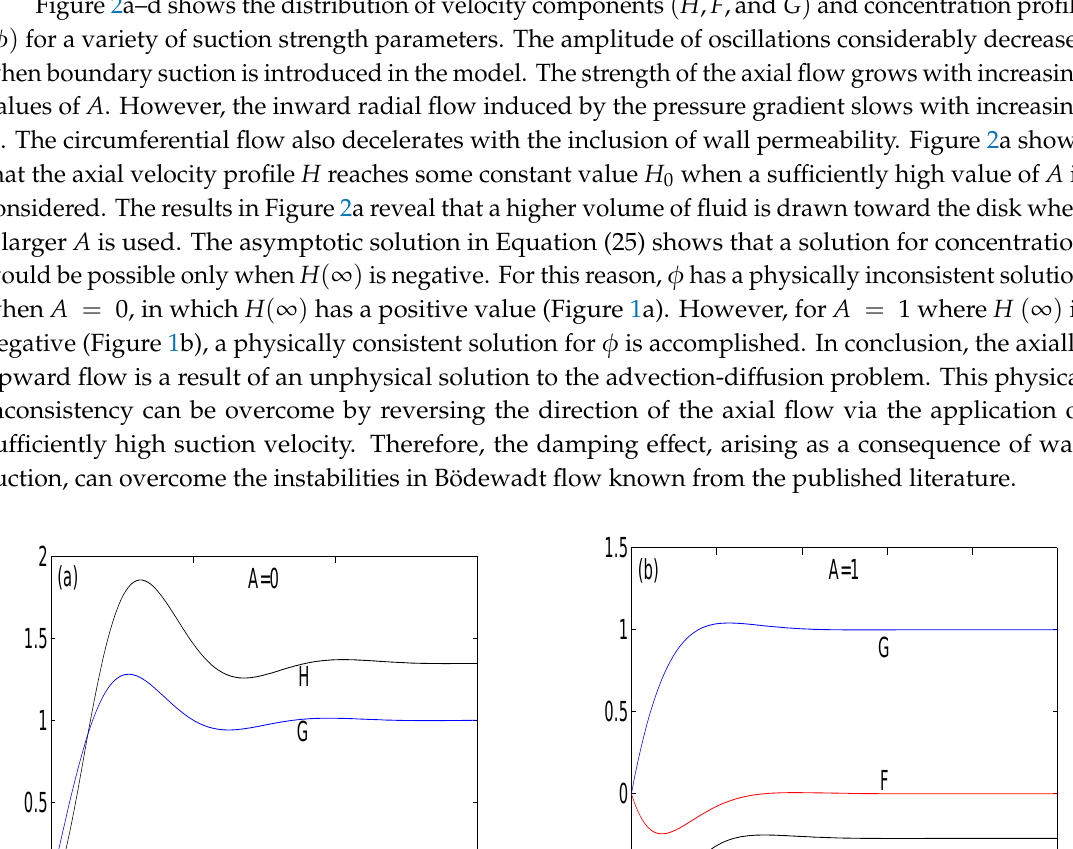
Figure 2. Velocity components ( 𝐻, 𝐹, and 𝐺 ) and 𝜙 for different values of 𝐴 . We determined the evolution of concentration profile 𝜙 at different values of involved parameters, as shown in Figure 3a–d. Graphs of 𝜙 against 𝜁 for various values of suction-strength parameters are depicted in Figure 3a. The concentration distribution has no meaningful solution in